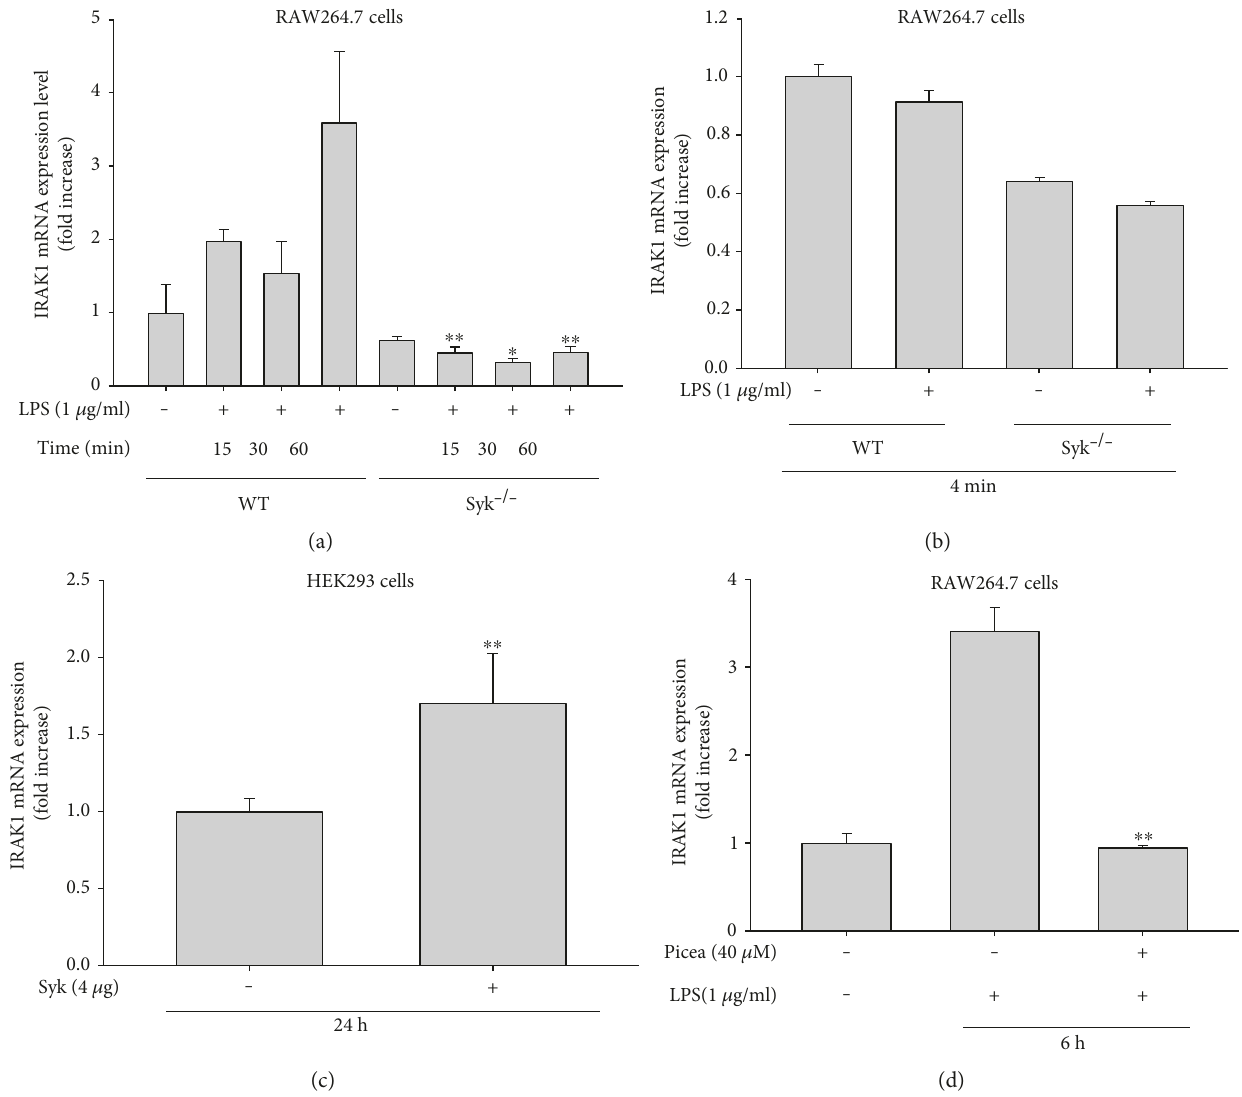
Figure 3: Syk impacts the transcriptional regulation of IRAK1 in LPS-treated RAW264.7 cells. (a and b) IRAK1 mRNA levels from RAW264.7-WT or RAW264.7-Syk − / − cells with or without LPS (1 μ g/ml) treatment, as determined by real-time PCR. (c) IRAK1 mRNA levels from HEK293 cells transfected with Syk, as determined by real-time PCR. All data are expressed as the mean ± SD of three independent replicate experiments. ∗ p < 0 05 and ∗∗ p < 0 01 compared to the control group (LPS alone) or normal